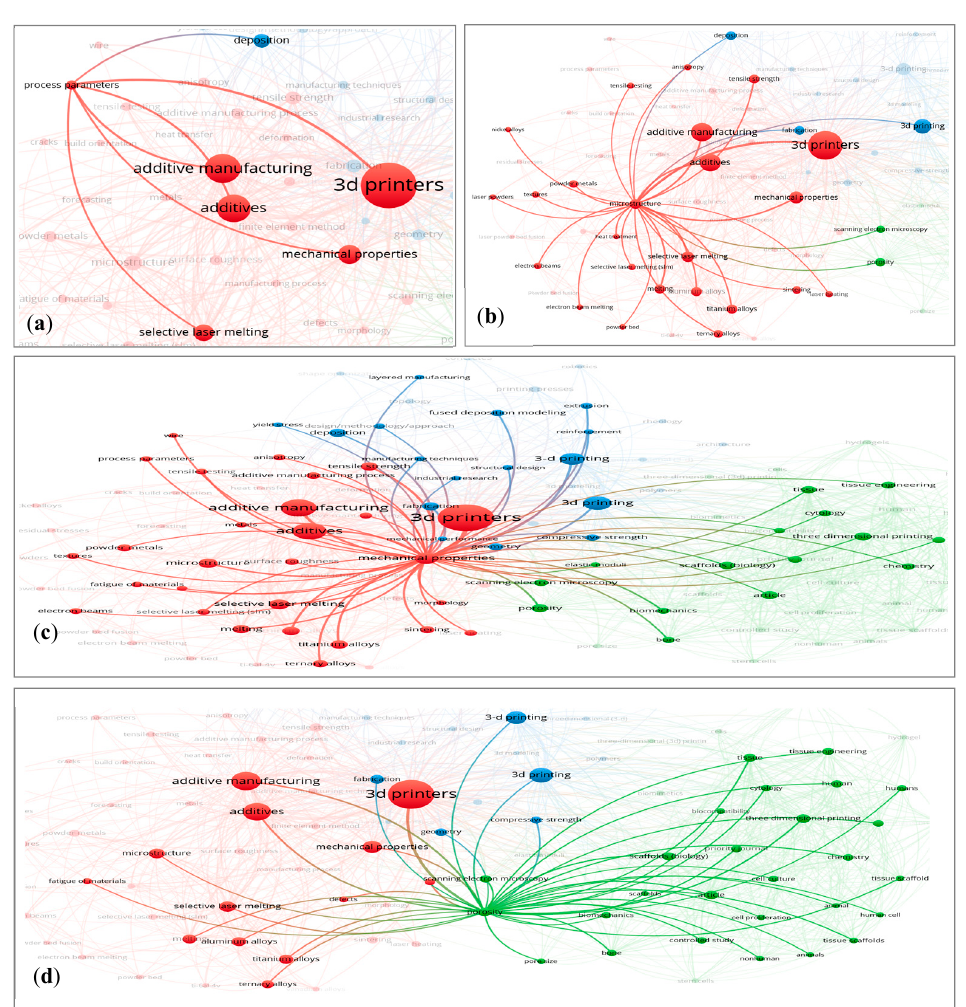
Figure 5. Co-occurrence analytical map of selected keywords created on bibliographic Scopus data for each group of keywords within and outside their individual groups: ( a ) process parameter network map; ( b ) microstructure network map; ( c ) mechanical properties network map; ( d ) porosity network map. Note: the minimum number of co-occurrences of keywords was 40, with a minimum strength of